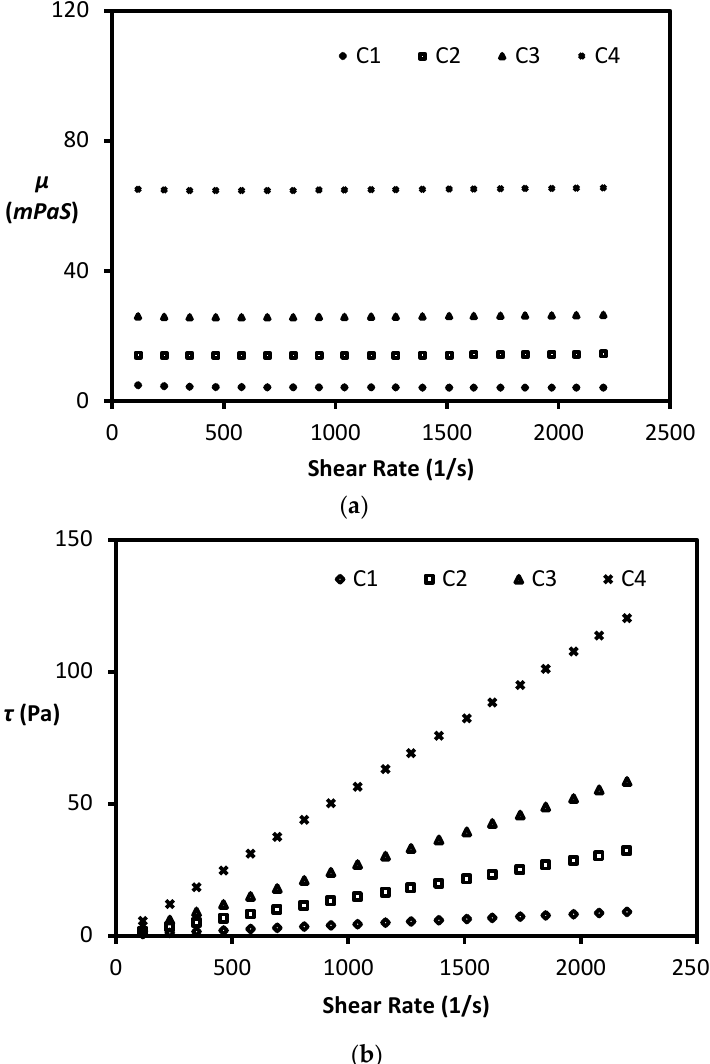
Figure 7. Rheological fluid properties: ( a ) dynamic viscosity versus shear rate and ( b ) shear stress versus shear rate.